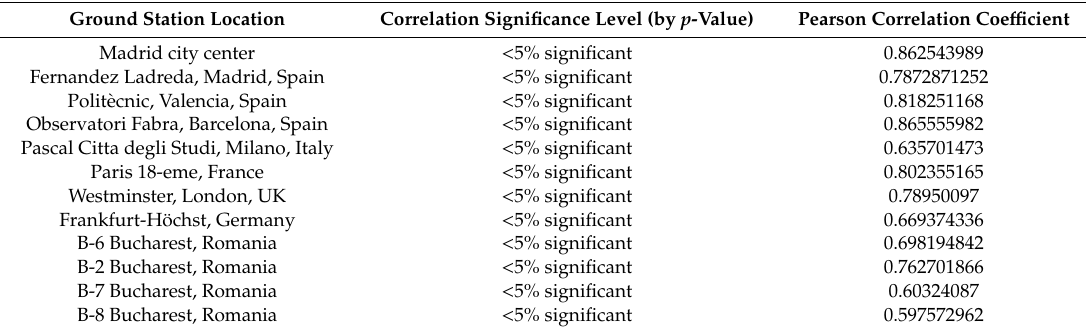
Table 1. Correlation statistics results for di ff erent locations between both variables of satellite-based and ground-based